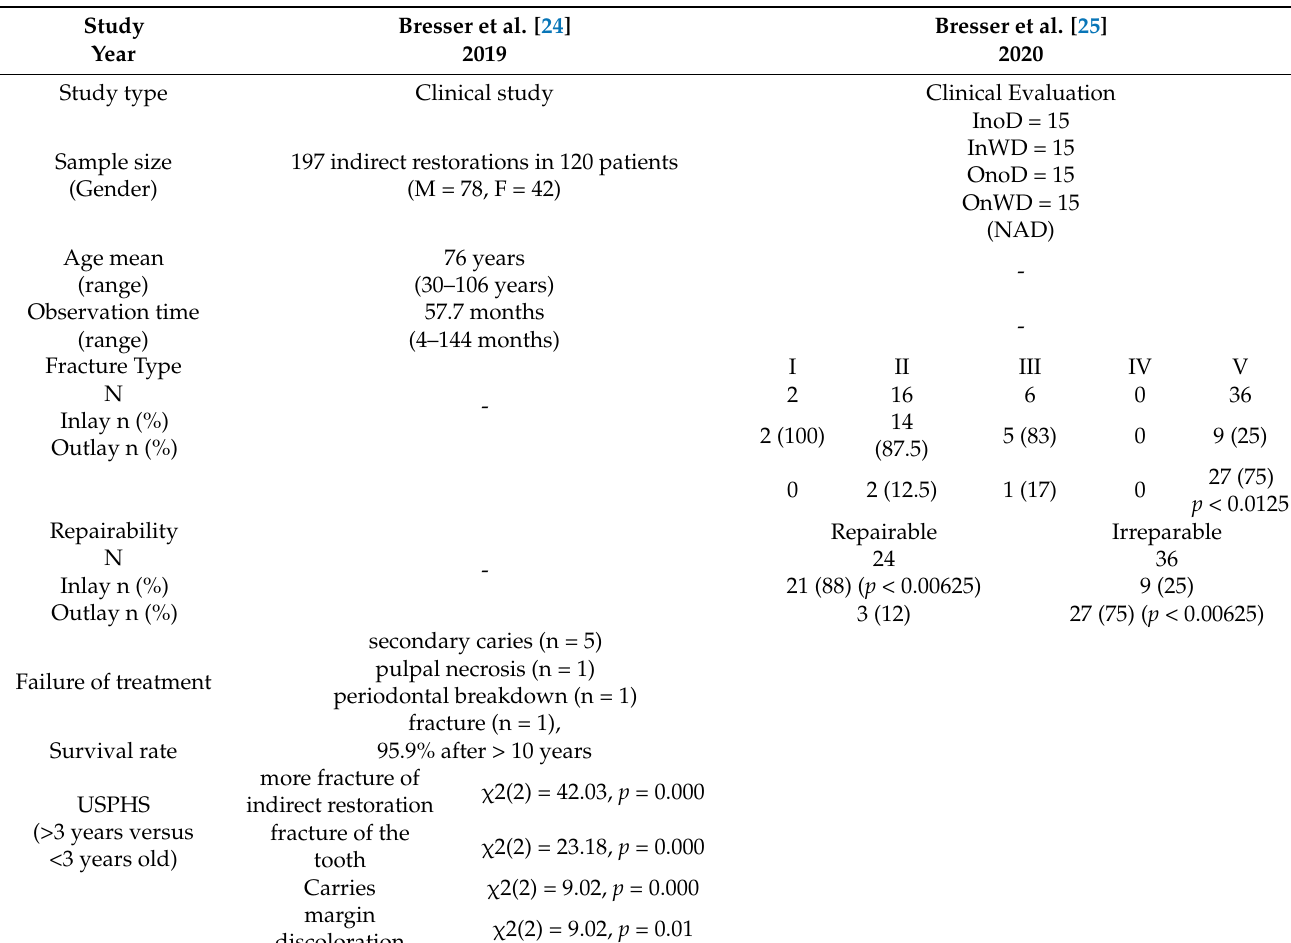
Table 2. Summary table of studies for